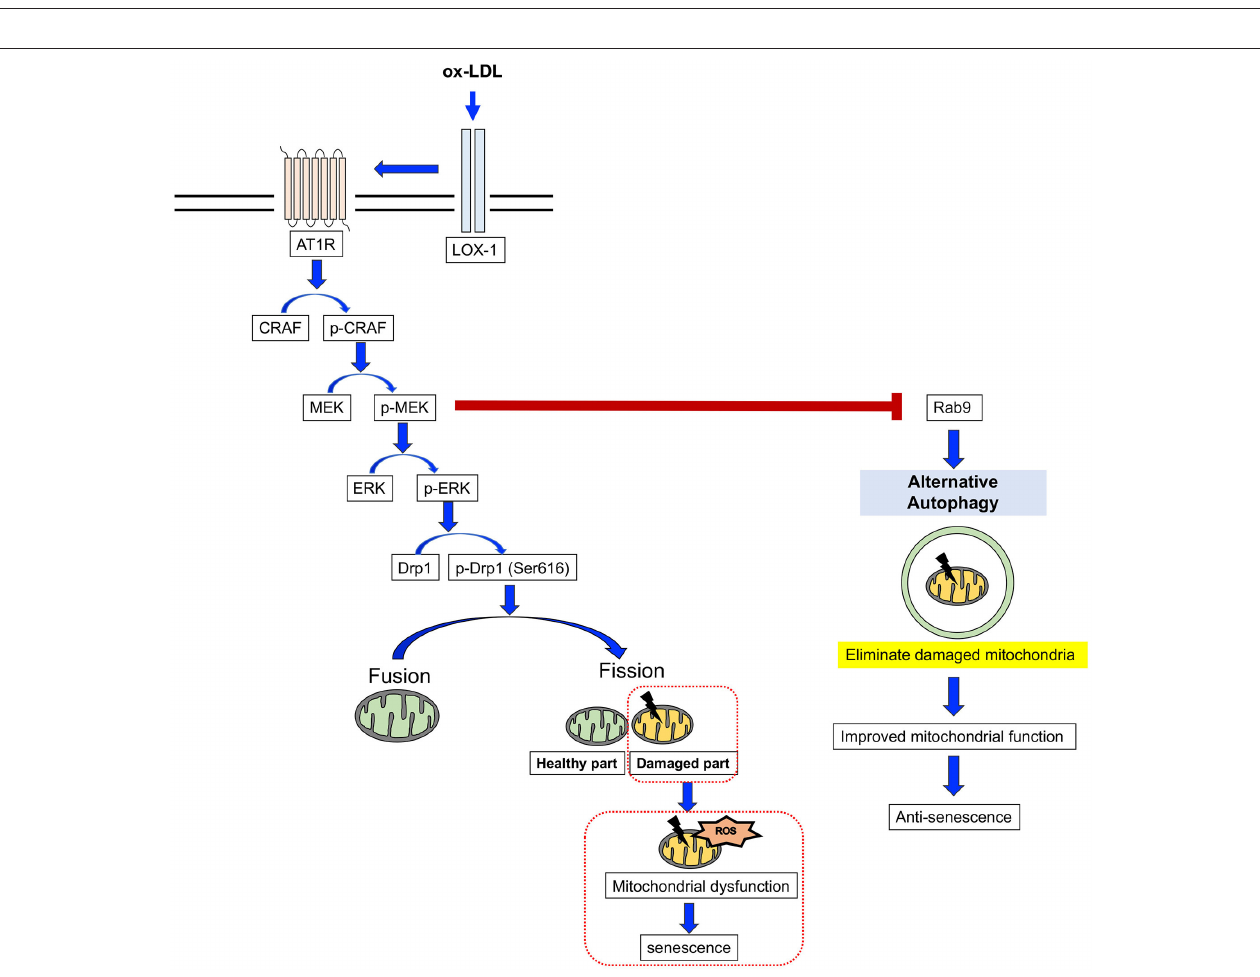
FIGURE 9 | The mechanism for the AT1R inhibition of anti-senescence through mitochondrial quality control. ox-LDL induced mitochondrial fission through the association of LOX-1 and AT1R and the CRAF/MEK/ERK pathway, resulting in mitochondrial dysfunction and senescence. AT1R inhibition attenuated senescence by suppression of this cascade and induced Rab9-dependent alternative autophagy through the CRAF/MEK axis and aspects of the mitochondrial quality control process in human